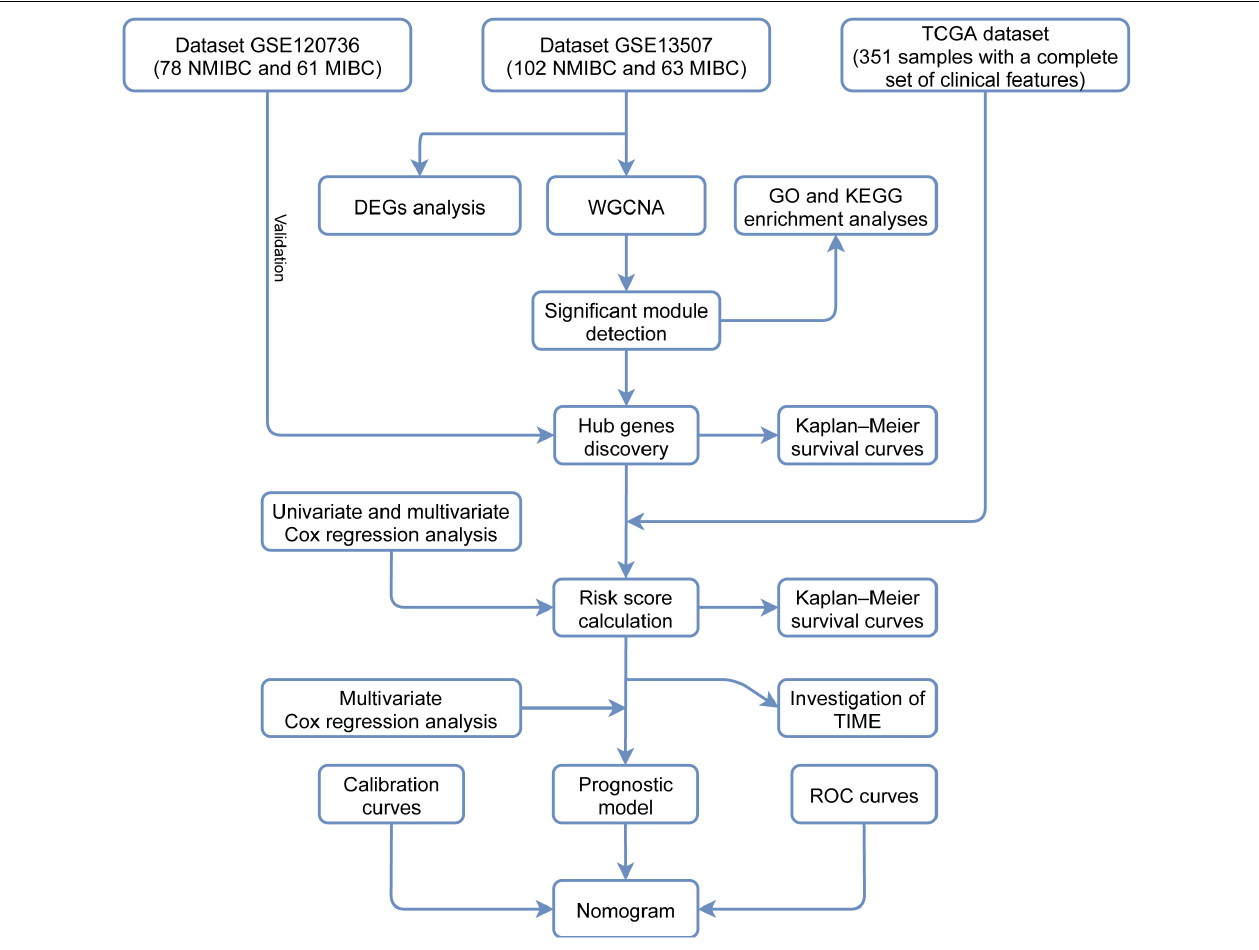
FIGURE 1 | A flowchart depicting the entire study